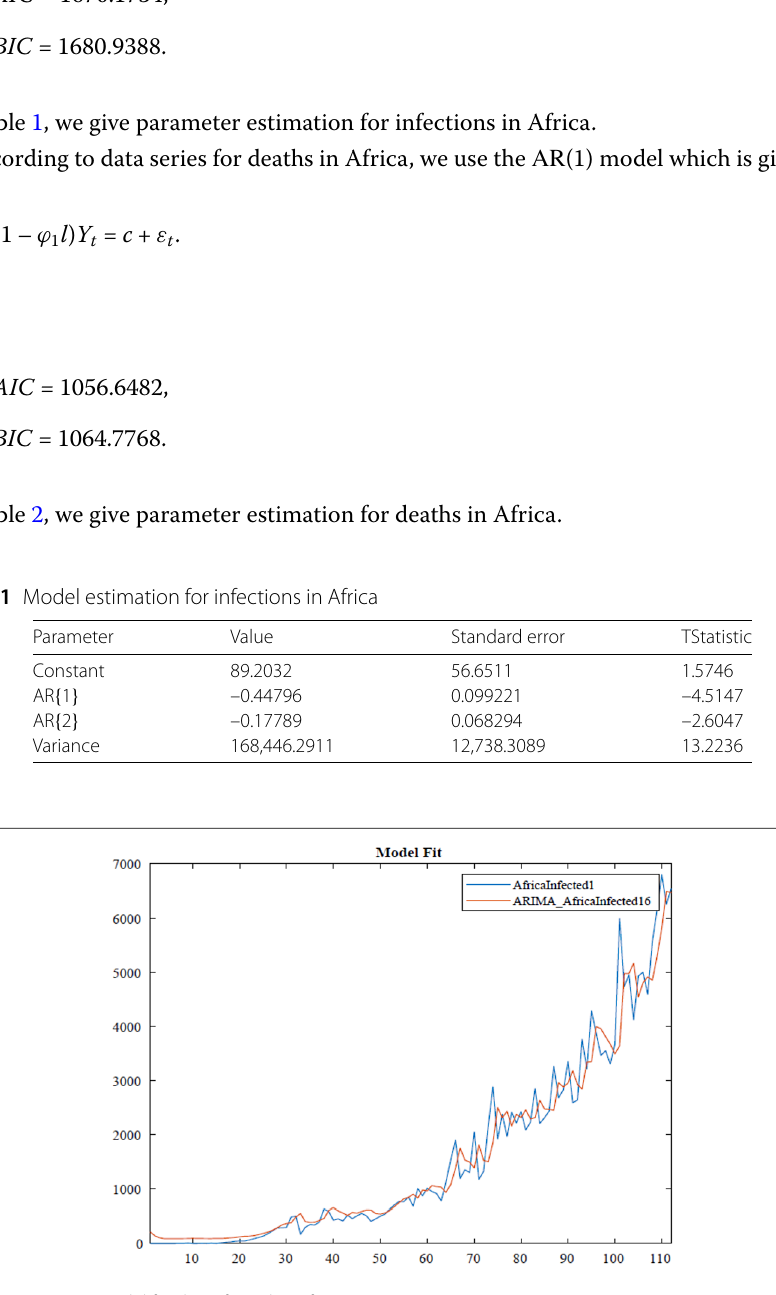
Figure 3 ARIMA model for the infected in